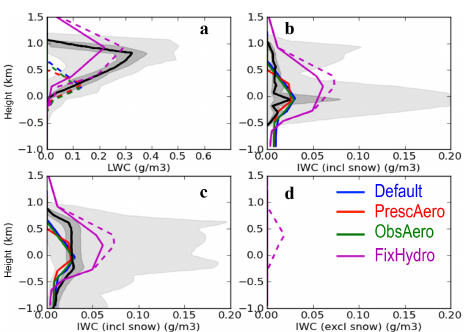
Figure 3. LWC and IWC profiles as a function of scaled height ( z/z b − 1) for MPACE-B. Dashed lines indicate values before micro- physics and solid lines indicate values after microphysics. (a) LWC profiles as function of scaled height. Dark shaded region ranges, light shaded region, and black solid line depict the median value, the inner 50% envelope, and the outer 50% envelope of the high frequency observed aircraft data, respectively (from K09). (b) The same as Fig. 3a but for IWC (including snow). (c) Same as Fig. 6b but using radar data from K09 as observations. (d) Same as Fig. 3b but excluding